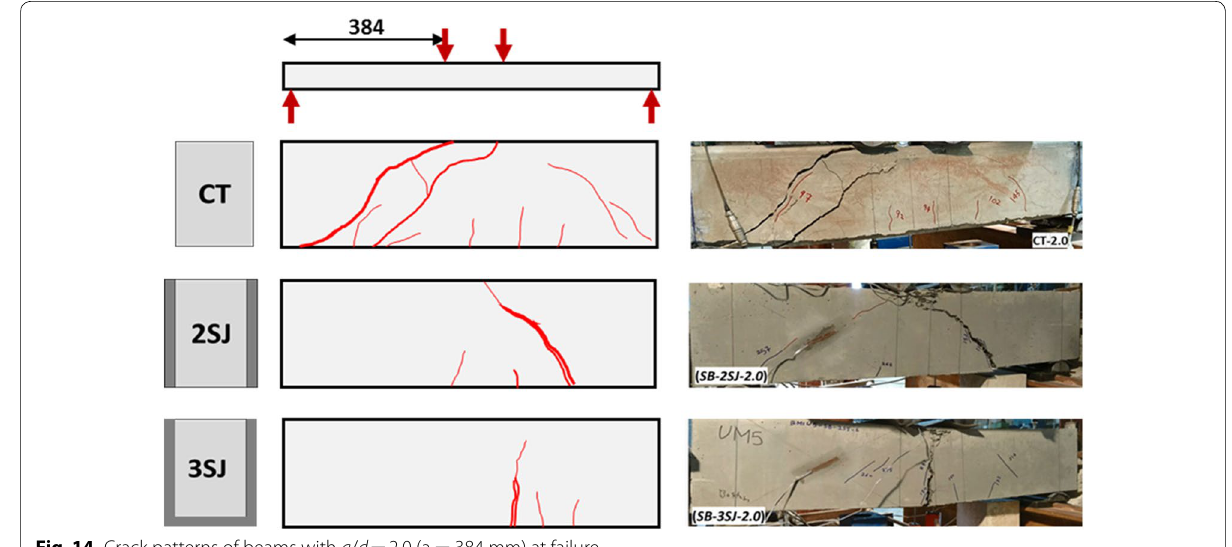
Fig. 14 Crack patterns of beams with a / d